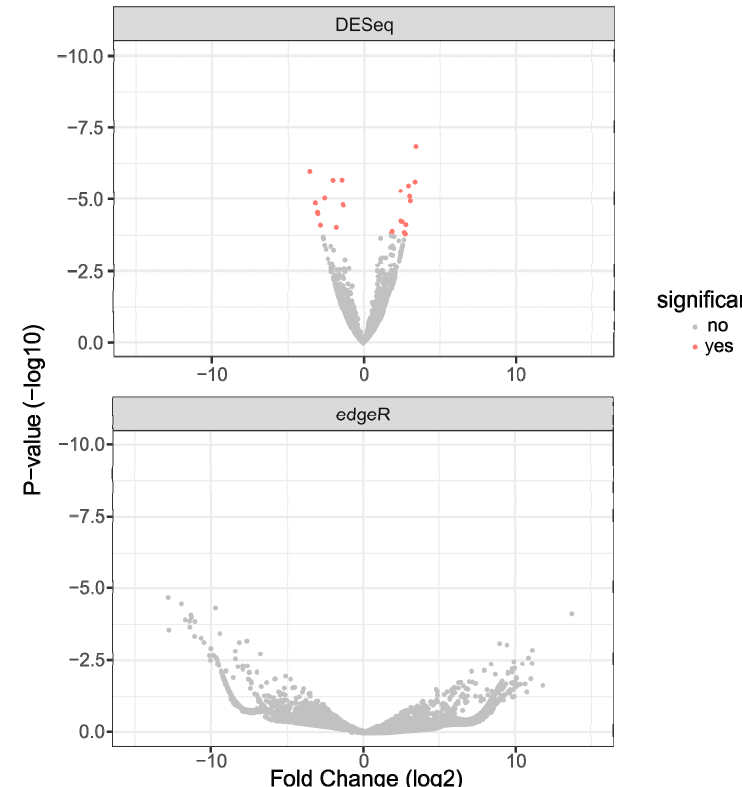
Figure 1. Volcano plots from DESeq2 and edgeR for 2 dpi differential gene expression; Volcano plots from DESeq2 (top panel) and edgeR (bottom panel) of differentially expressed genes from 2 dpi. DESeq2 was performed by aligning reads to the Aedes albopictus reference genome. edgeR analysis was done on reads that did not align to the reference genome and were aligned to the custom transcriptome.